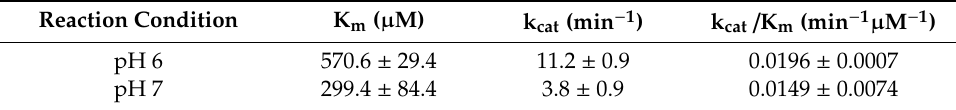
Table 2. Kinetic parameters of BsGT110 toward GAA at pH 6 and pH